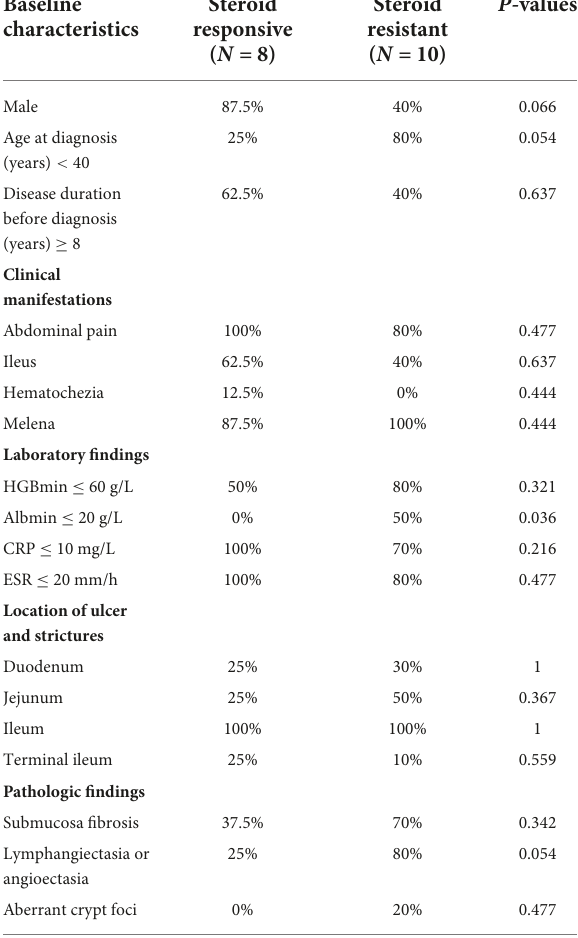
TABLE 3 The differences of baseline, and clinical characteristics in CMUSE between steroids-response